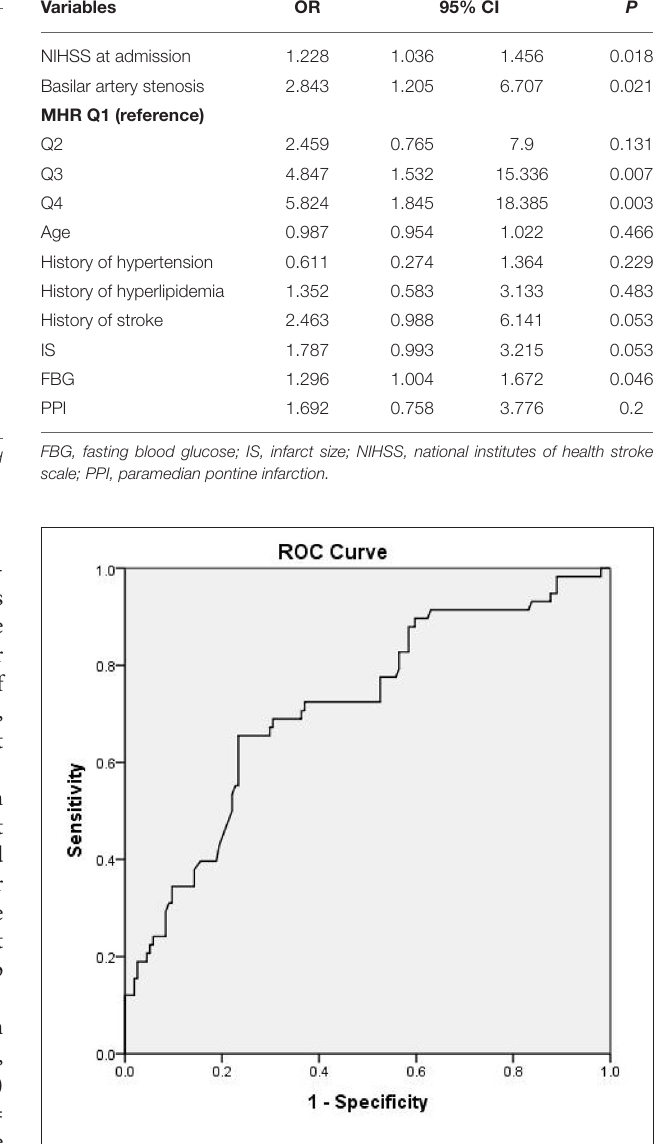
FIGURE 3 | Receiver operating characteristic (ROC) curve of the relationship between monocyte to high-density lipoprotein ratio (MHR) and early neurological deterioration